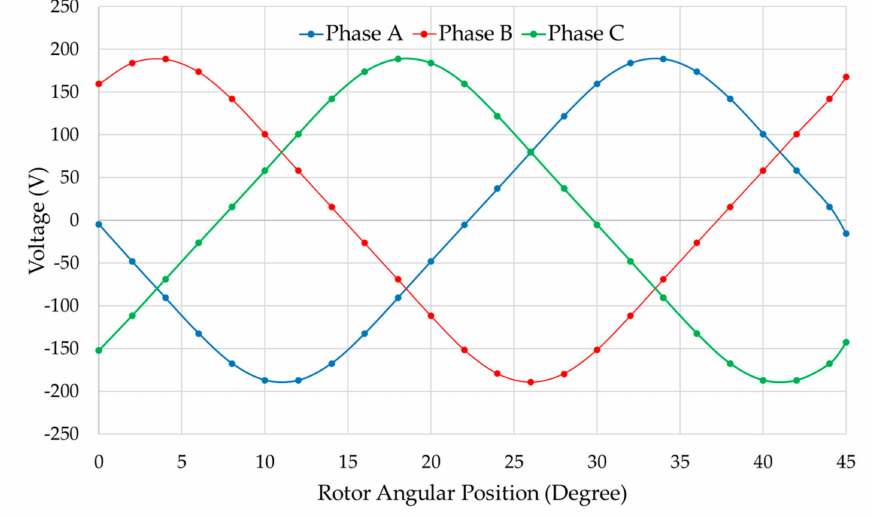
Figure 6. The back electromotive force at